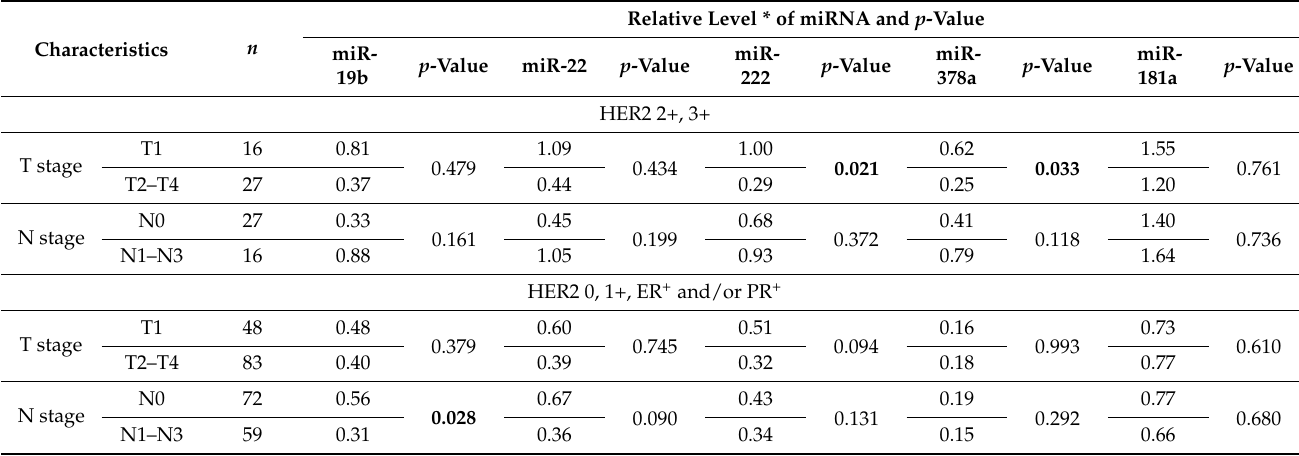
Table 6. Association of miR-19b, miR-22, miR-222, miR-378a and miR-181a expression levels with clinicopathologic characteristics of HER2-overexpressing/amplified tumors and ER+, PR+, HER2 0, 1+ BC.